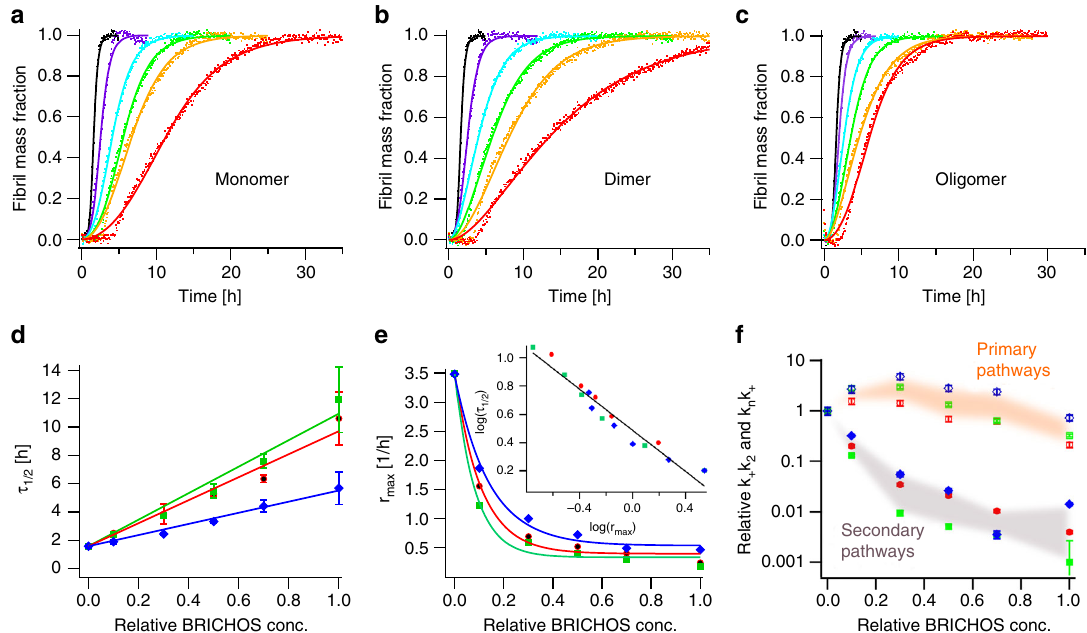
Fig. 3 Kinetics analysis of rh Bri2 BRICHOS species effects on A β 42 fi bril formation. a – c Individual fi ts (solid lines) of normalized and averaged aggregation traces (dots) of 3 µ M A β 42 in the presence of 0 (black), 10 (violet), 30 (cyan), 50 (green), 70 (yellow) and 100% (red) Bri2 BRICHOS (molar percentage ffiffiffiffiffiffiffiffiffi p ffiffiffiffiffiffiffiffiffiffi p k n k þ k þ k referred to monomeric subunits) with the combined rate constants and as free fi tting parameters. d , e The sigmoidal fi tting parameter τ 1/2 2 and r max exhibit a linear and mono-exponential dependence, respectively, on the relative Bri2 BRICHOS concentration for all species, i.e., the monomer (red), dimer (green) and oligomer (blue). Their logarithmic values fall on a line, indicating the same aggregation mechanism in the presence of all Bri2 BRICHOS species (inset graph). f The dependencies of the relative combined rate constants obtained from the fi ts in a – c reveal a strong effect of all Bri2 BRICHOS species on secondary nucleation ( k + k 2 , closed symbols and gray area), but not on primary ( k n k + , open symbols and orange area) pathways. The data in (d-e) are presented as means ± standard deviations of 3 – 4 replicates of experiments that have been repeated at least fi ve times with qualitatively similar results. The errors in f are presented as fi tting